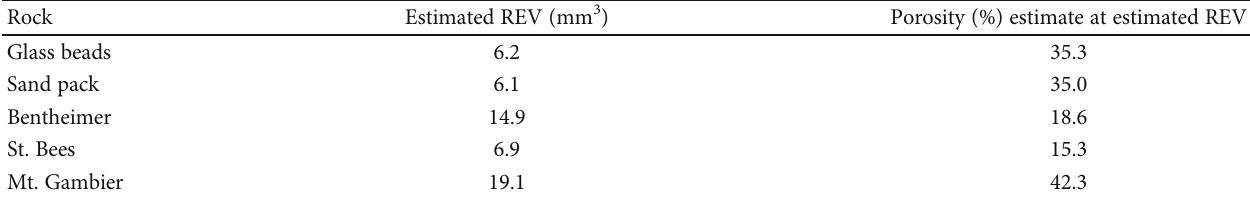
Table 10: Estimates of REV and its corresponding porosity as calculated using the linear regression models. Estimates are presented in original